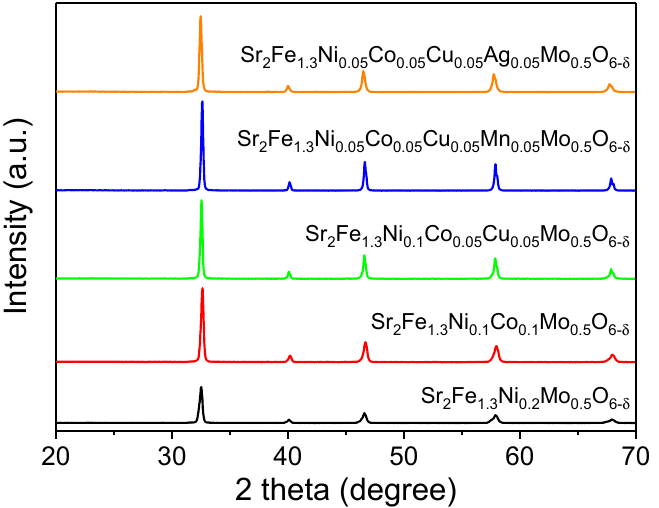
Figure 7. XRD patterns of several other Mo-containing perovskites synthesized by the as-proposed solid-state synthesis process.